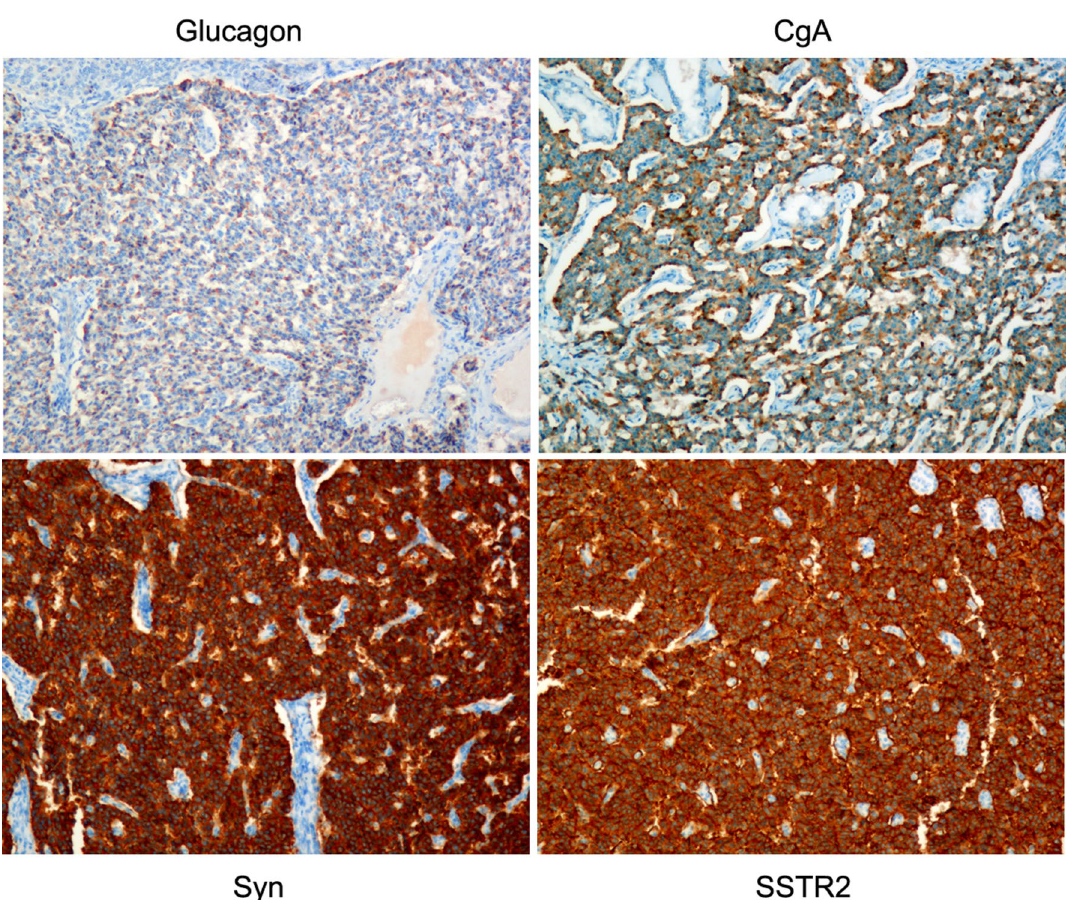
Figure 4. Positive immunohistochemical staining for glucagon, Cga, Syn and SSTR2 (×